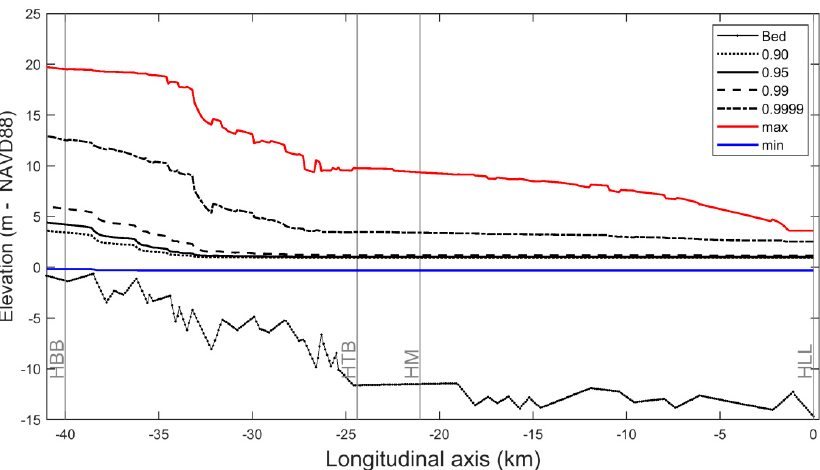
Figure 4. Maximum (red), minimum (blue) water surface elevations and percentiles (90th, 95th, 99th, and 99.99th) of daily water levels at each river calculation point obtained by inferring the BN 182,500 times and modeling the resulting water surface profile.